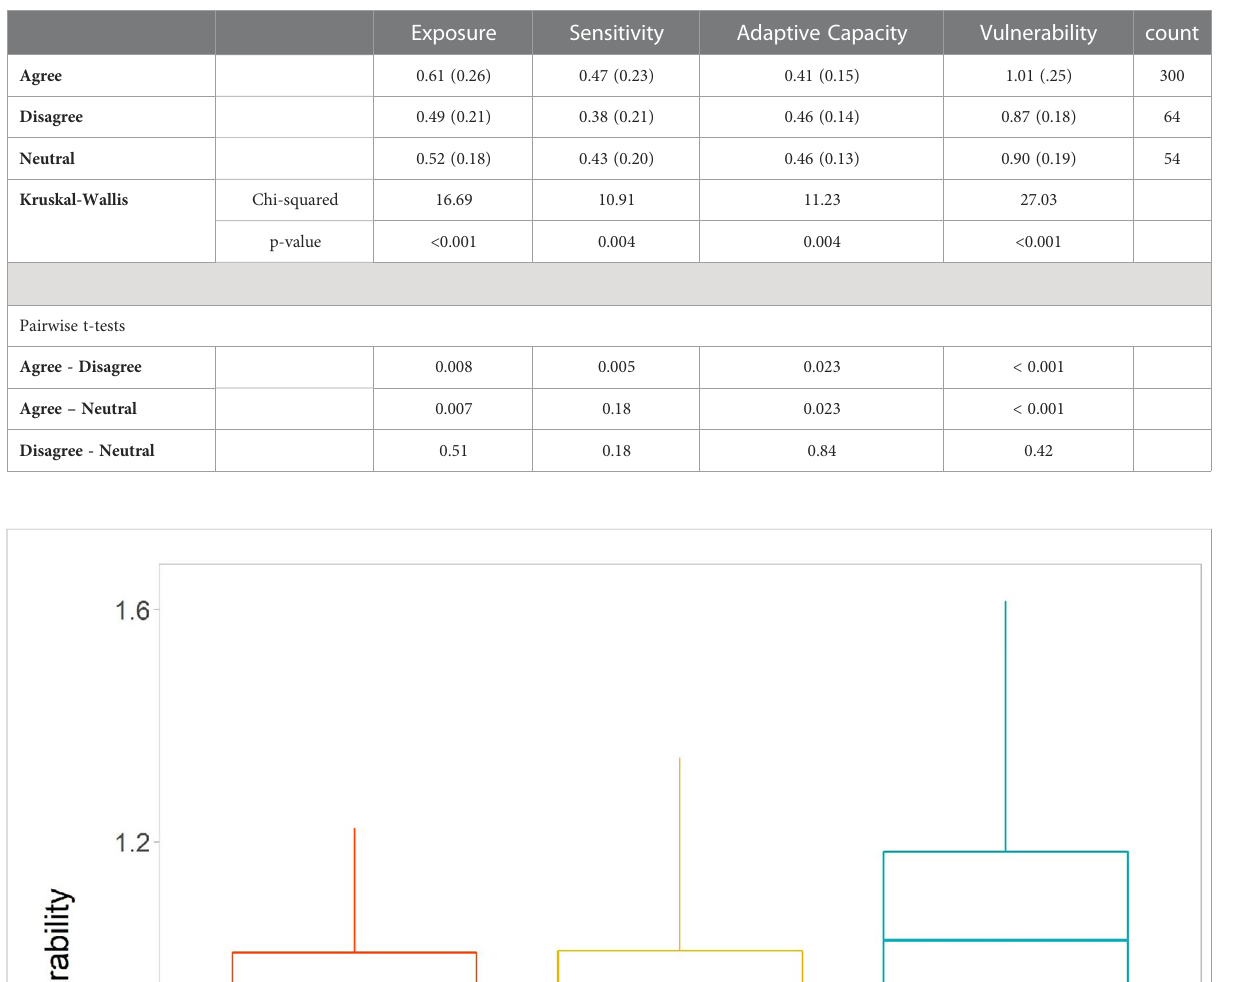
TABLE 2 Mean (and standard deviation) of the vulnerability scores aggregated by belief if climate change is occurring, and results of the Kruskal- Wallis analysis of variance (ANOVA) and pairwise